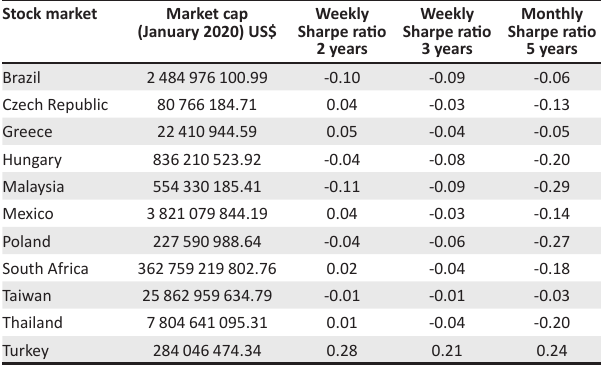
TABLE 1: Characteristics of stock markets. Stock